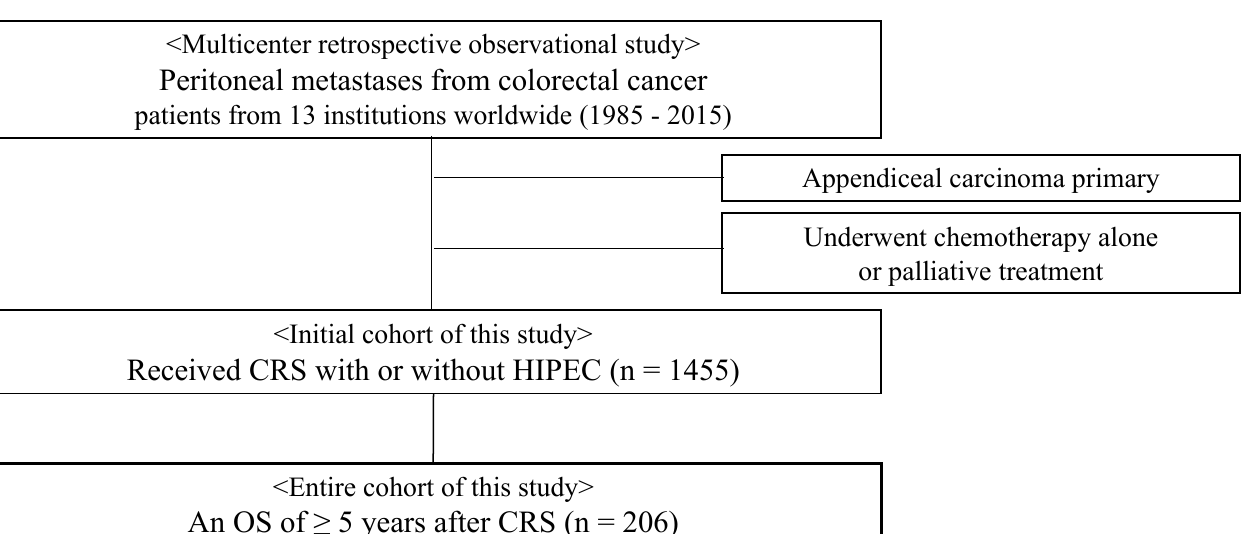
Figure 1. Flow diagram of patient enrollment. Abbreviations: CRS, cytoreductive surgery; HIPEC, hyperthermic intraperi- toneal chemotherapy; OS, overall survival. Table 1 summarized the baseline characteristics of this cohort. One hundred one male patients (49.0%) and one hundred five female (51.0%) were included, with a median age of